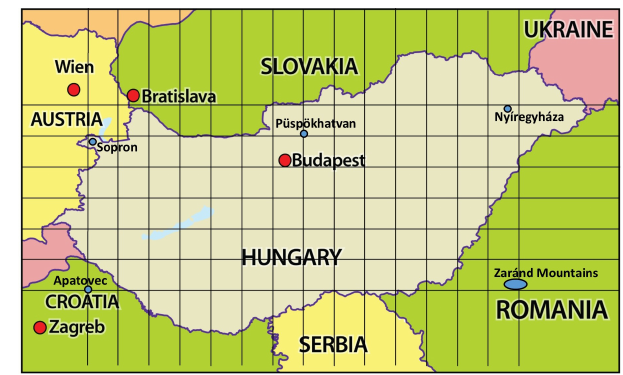
Figure 2. The map of the Carpathian Basin with the used grid